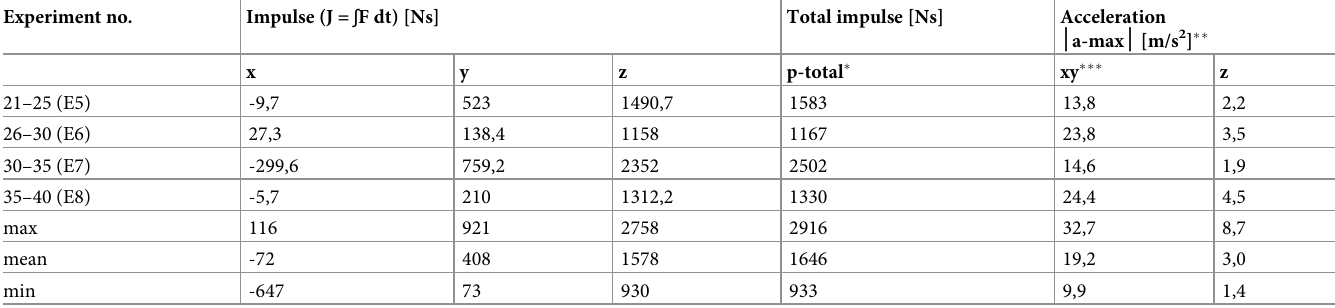
Table 5. Parameters of manual drilling, Part 2 (E+no = mean of 5 drilling procedures). Experiment no.